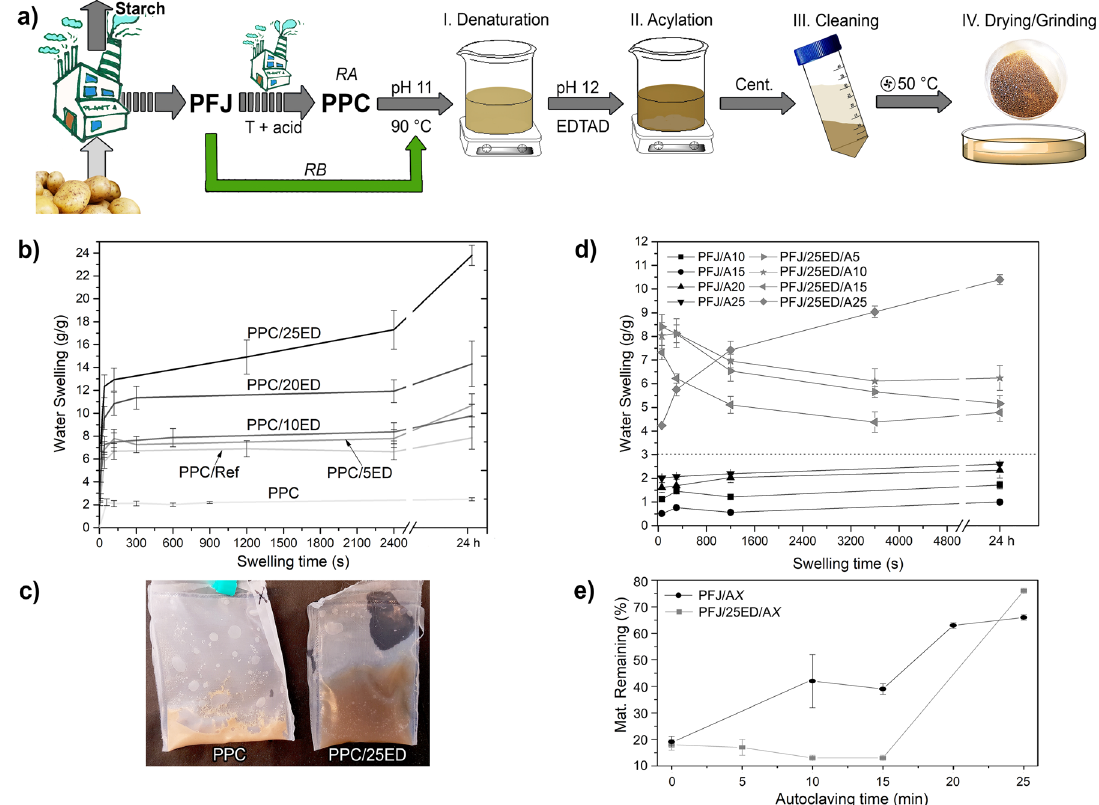
Fig. 1 Functionalisation protocol of the potato protein and swelling results. a Experimental protocol used for the functionalisation of the PPC (RA) and PFJ (RB). b Water free swelling capacity (FSC) of the acylated PPC samples at different EDTAD concentrations. c Representative sample of the swollen PPC and PPC/25ED (24 h). d Water FSC of the autoclaved PFJ and acylated PFJ samples. e acylated PFJ material remaining in the tea-bags after the 24 h water swelling at different autoclaving times. The dotted line in d separates the swelling transition between non and acylated PFJ samples. The “ X ” in e corresponds to the autoclaving time for the samples. Error bars represent ± one standard